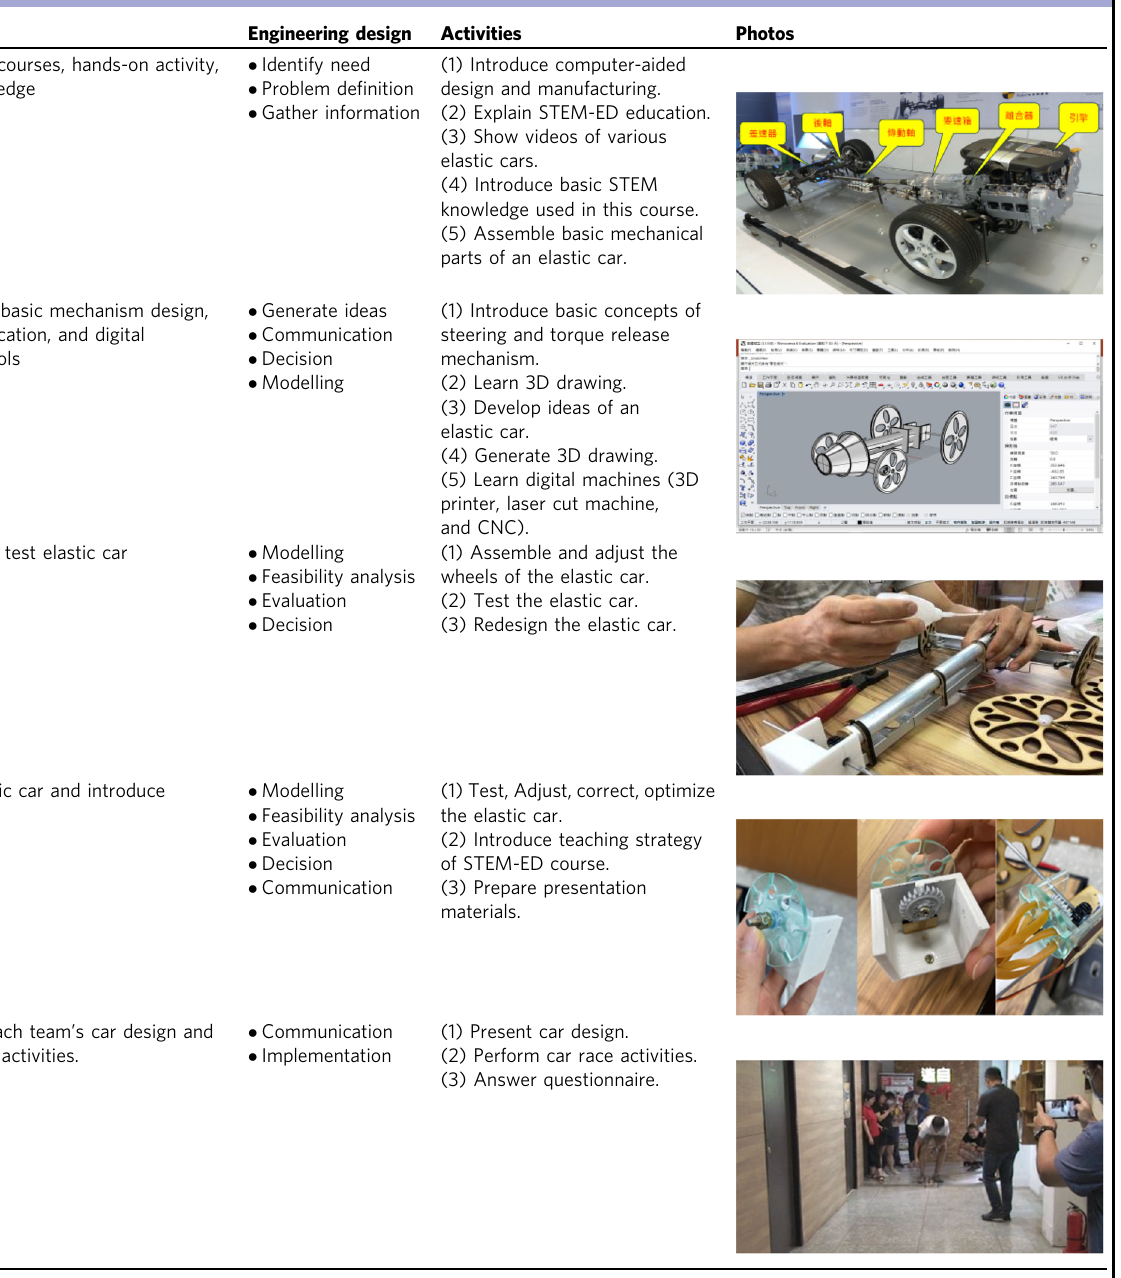
Table 1 Content of the 36-h STEM-ED empowerment